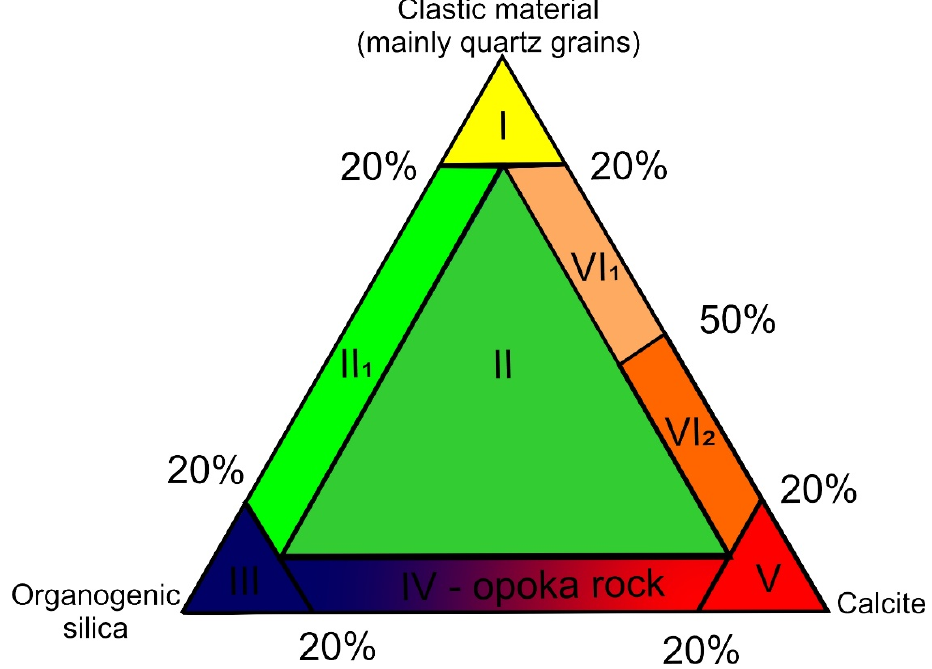
Figure 2. Position of the opoka rocks in the classification triangle: siliceous rocks—clastic rocks— calcareous rocks ([56], slightly changed). I—sands, sandstones, II—gaizes, II 1 —calcium—free gaizes, III—siliceous rocks, IV—opoka rocks, V—limestones, VI 1 —sandy and calcareous rocks, VI 2 —calcareous and sandy rocks.